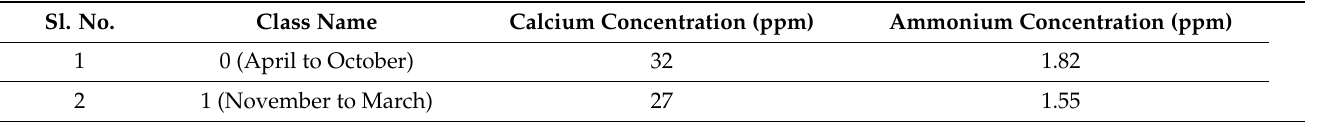
Table 1. The recommendation system for nutrient regulation in aquaponic environments. Sl.